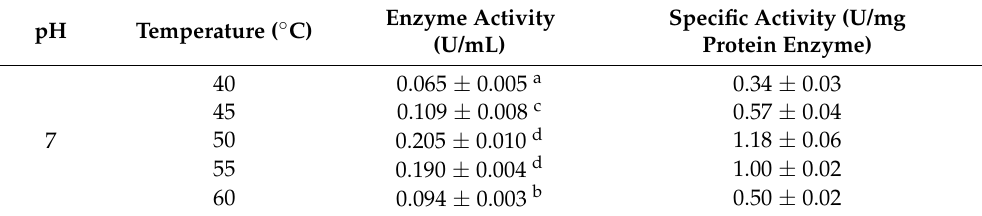
Table 1. Bromelain enzyme activity at various temperatures.